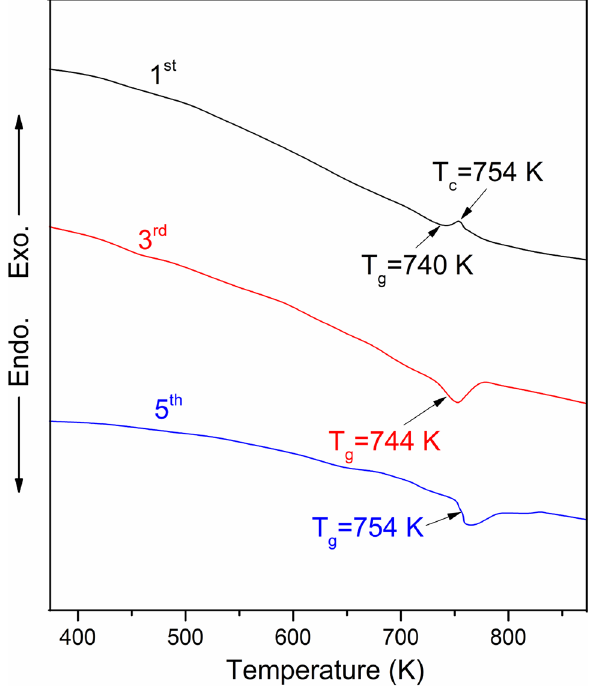
Fig. 2 DTA curves for the SnO–V2O5–SiO2 glass